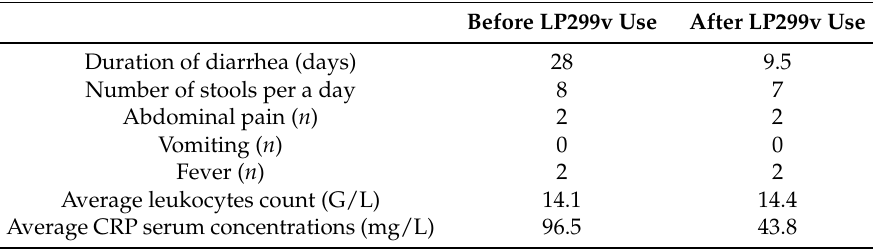
Table 4. During the year before the introduction of LP299v CDI was diagnosed in 21 patients. In two of them, the CDI recurrence was diagnosed after starting the LP299v prophylaxis. The analysis of the clinical features of the recurrence of CDI in two patients, in whom CDI was diagnosed, before and after initiation of Lactobacillus plantarum 299v prophylaxis, were presented. Before LP299v